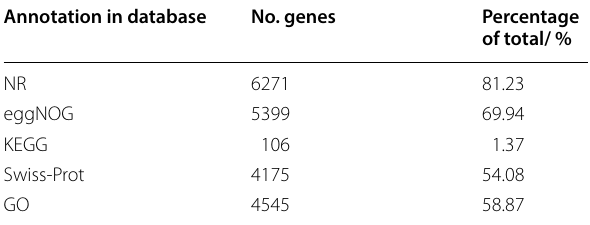
Table 4 Functions of